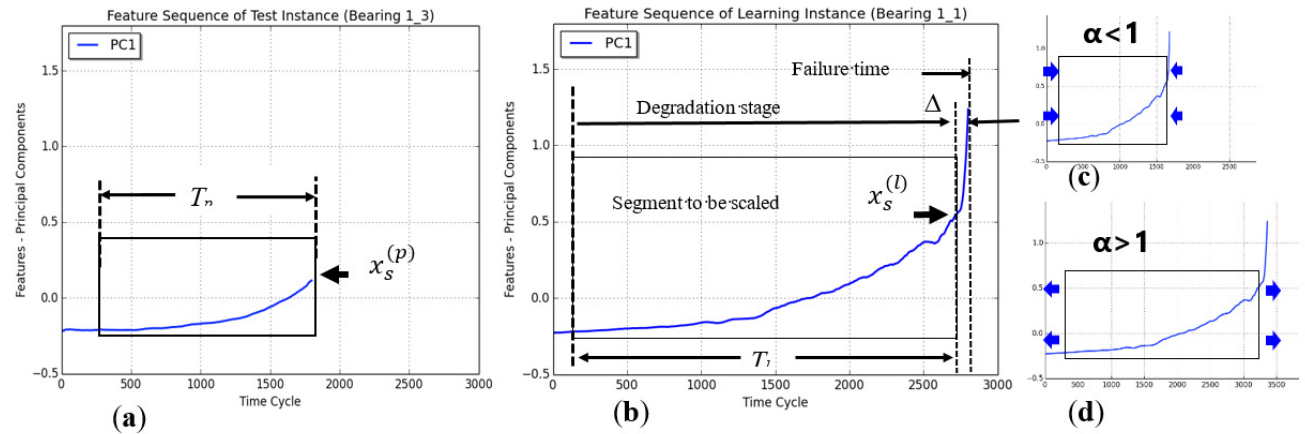
Figure 5. Example of data augmentation method–segment scaling: ( a ) Test instance Bearing1-3; ( b ) Learning instance Bearing1-1; ( c ) A shrunk feature sequence; ( d ) A stretched feature sequence.